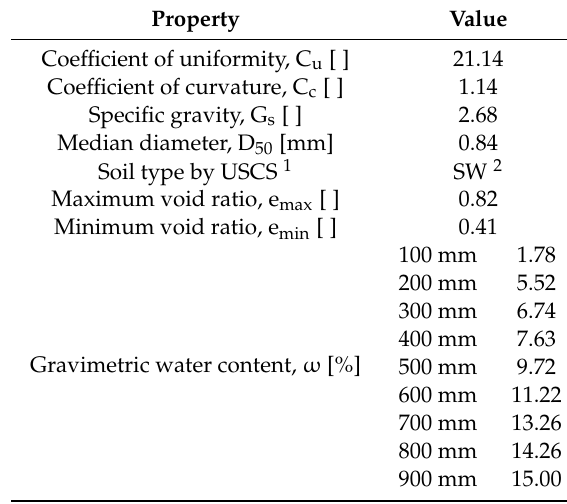
Table 1. Index properties of soils sampled in the experimental study site (Seoul, Republic of